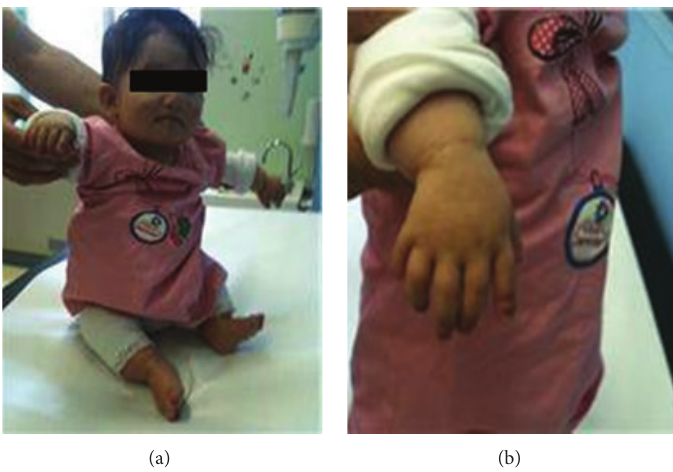
Figure 3: Clinical photos of patient from Family 1 depicting short upper and lower limbs and polydactyly.